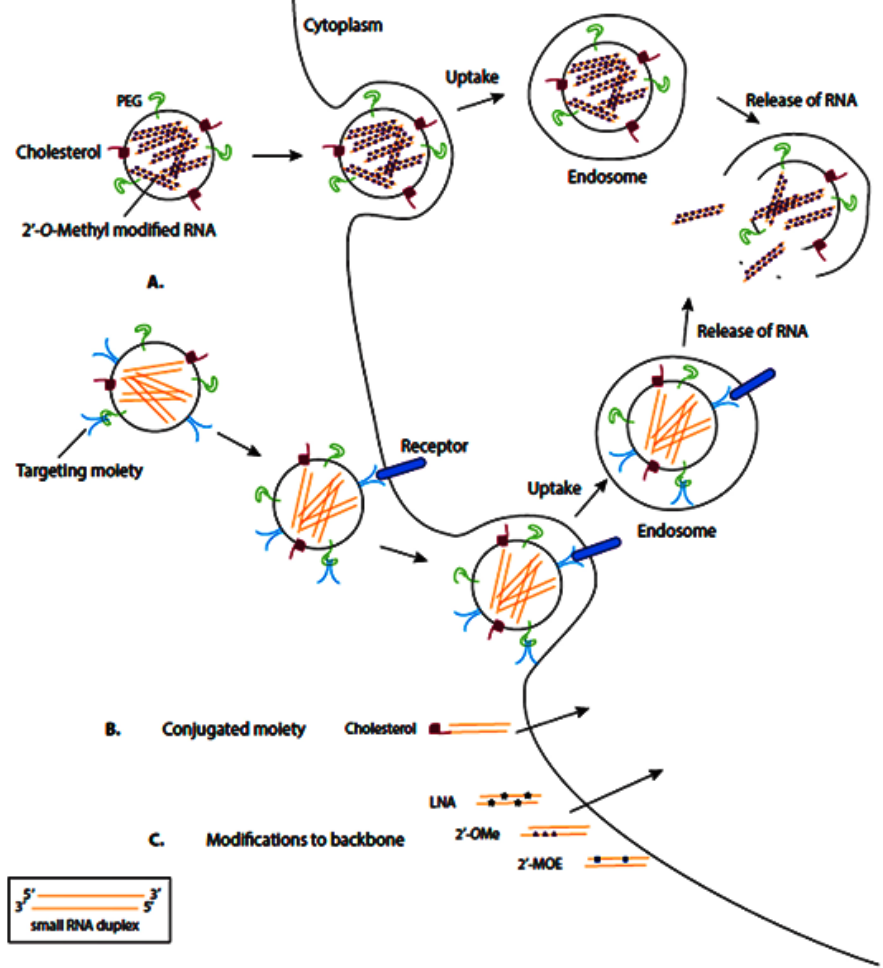
Figure 4. Schematic representation of common delivery methods for RNA-based therapies. LNA: locked nucleic acid (2 ′ 4 ′ -methylene; 2 ′ OMe: 2 ′ -O-methyl; 2 ′ MOE: 2 ′ -O-methoxyethyl. Nanocarriers can enter the target cells via endocytosis ( A ), direct conjugation to moieties ( B ), and chemical modification ( C ). Reprinted from [100].